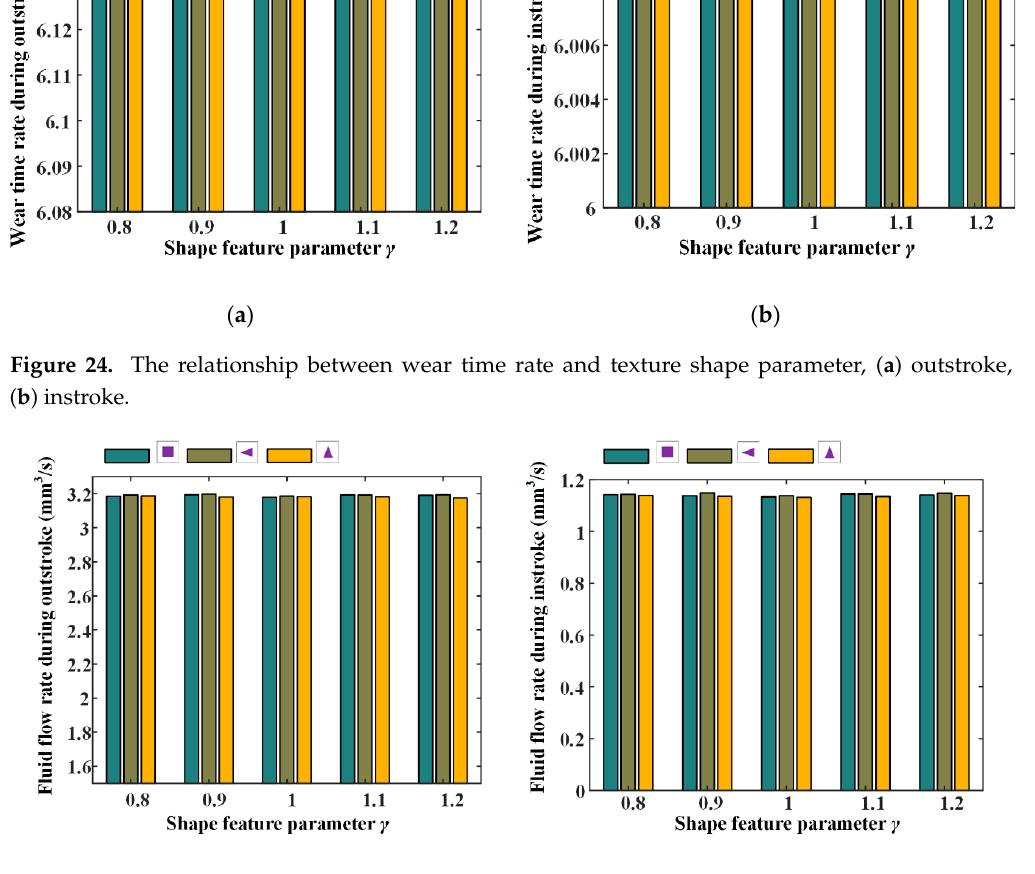
Figure 25. The relationship between fluid flow rate and texture shape parameter, (a) outstroke (b) instroke.